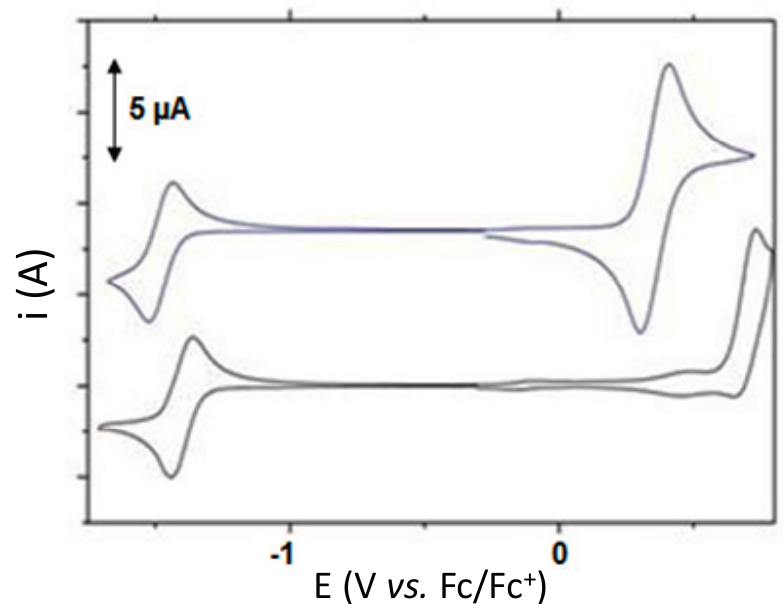
Figure 5. Cyclic-voltammograms of S10 (upper) and S11 (lower), run in freshly distilled dichloromethane at a sweep rate of 50 mV·s − 1 , showing reversible reduction potential waves (both S10 and S11 ) and reversible oxidation potential wave ( S10